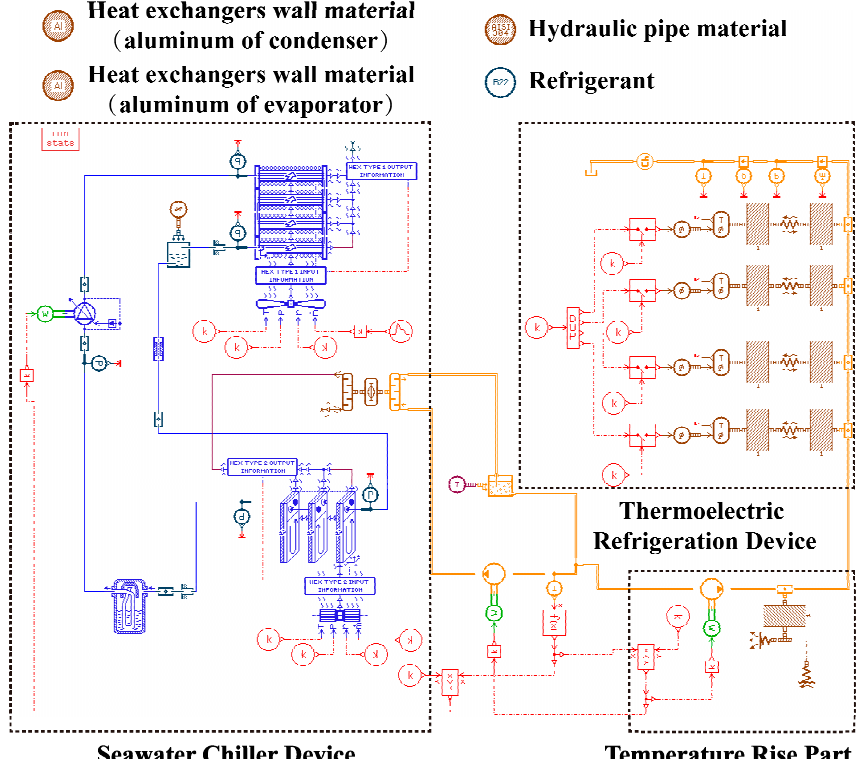
Figure 9. The model design sketch of simulation.